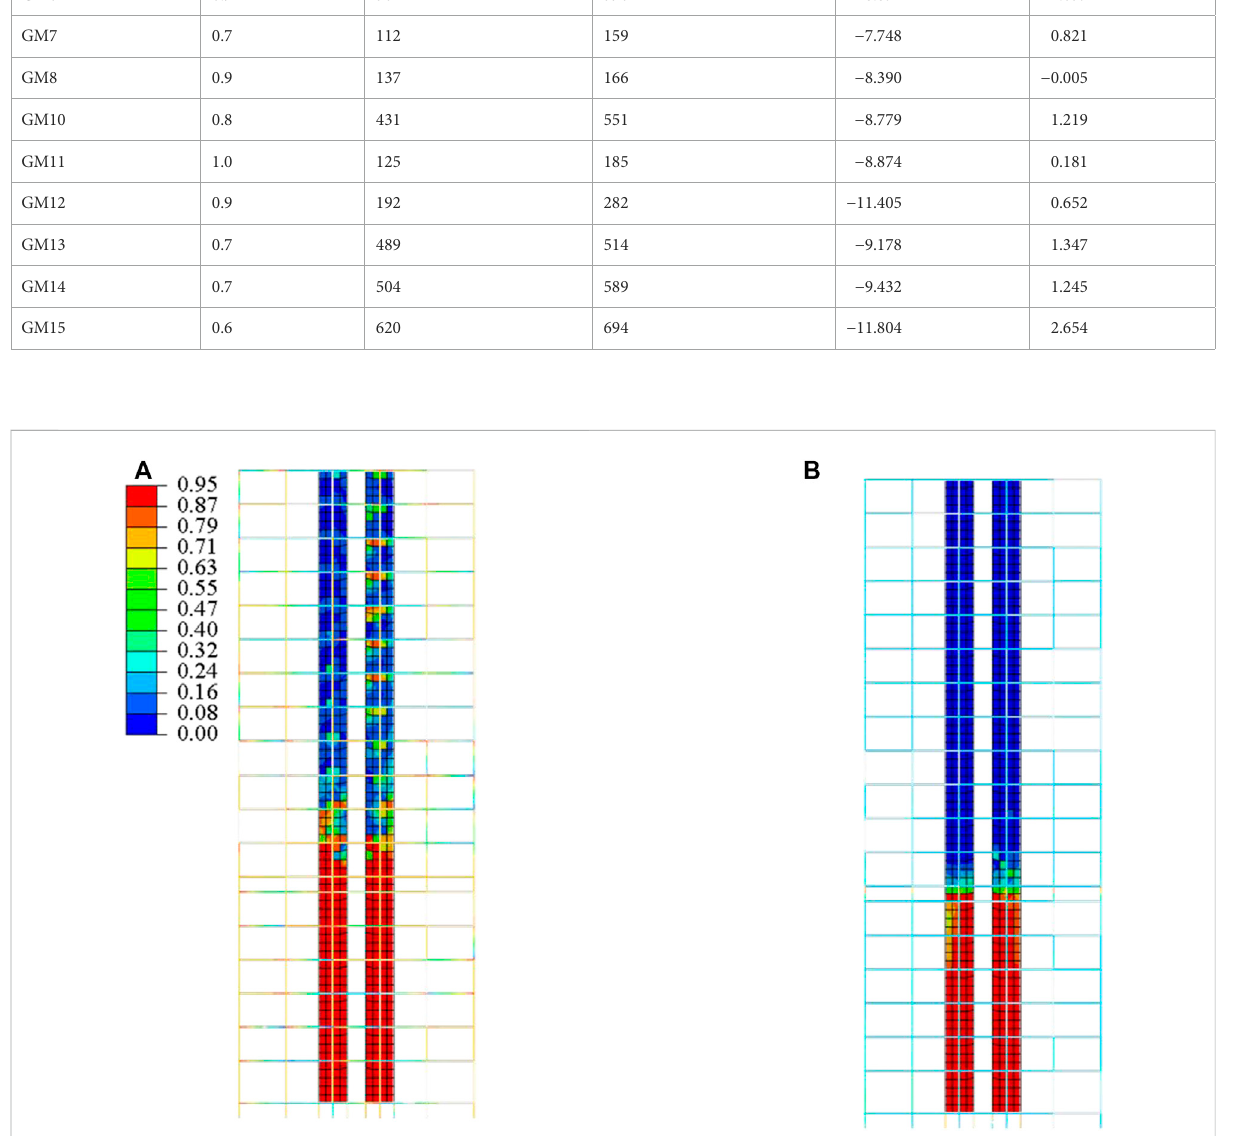
Frontiers in Earth